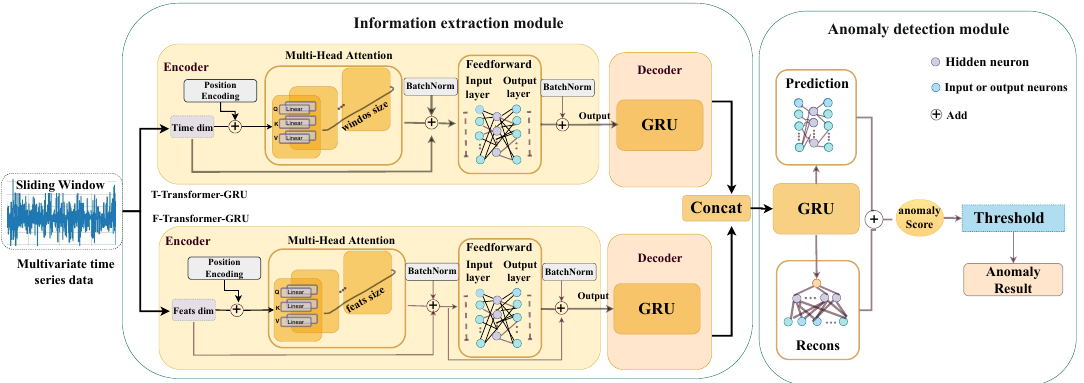
Figure 3. The Anomaly-PTG model extracts the long-distance time dependence and feature relations of time series data at the same time through the parallel transformer GRU and re-models the time series data. The timing sequence information is fed into the prediction network and reconstruction network, and the anomaly scores of the two are combined as the total anomaly scores of the model by the way of optimal combination to infer the occurrence of the